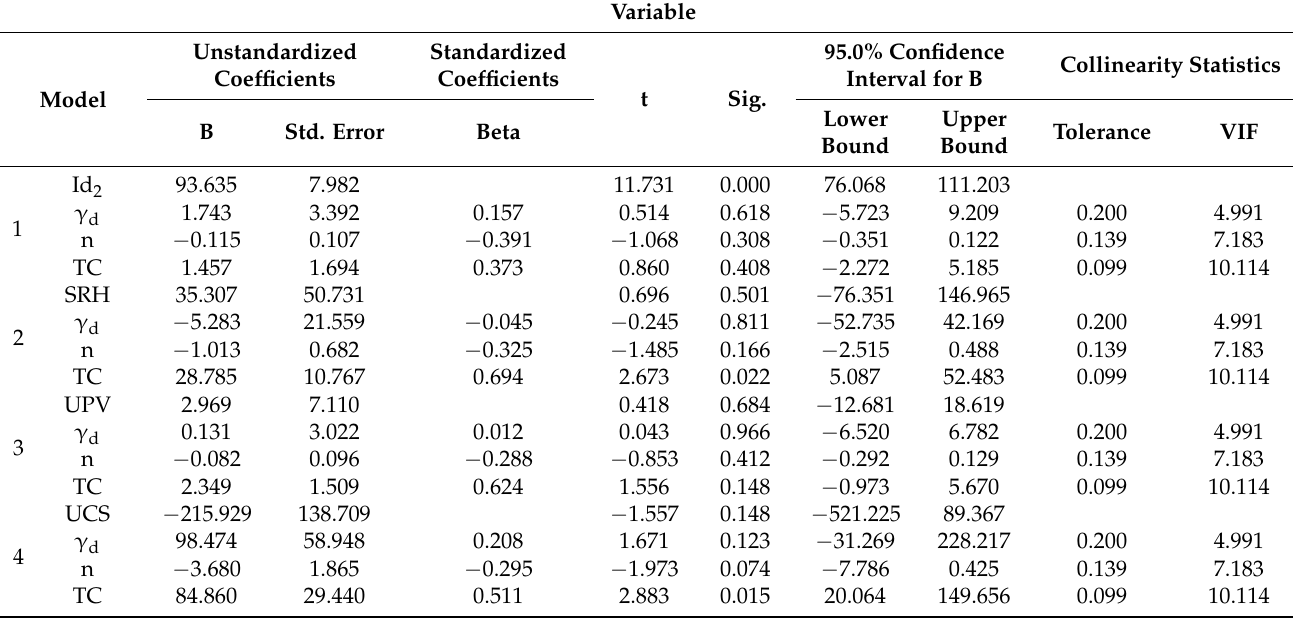
Table 7. Multiple regression coefficients for the developed models.